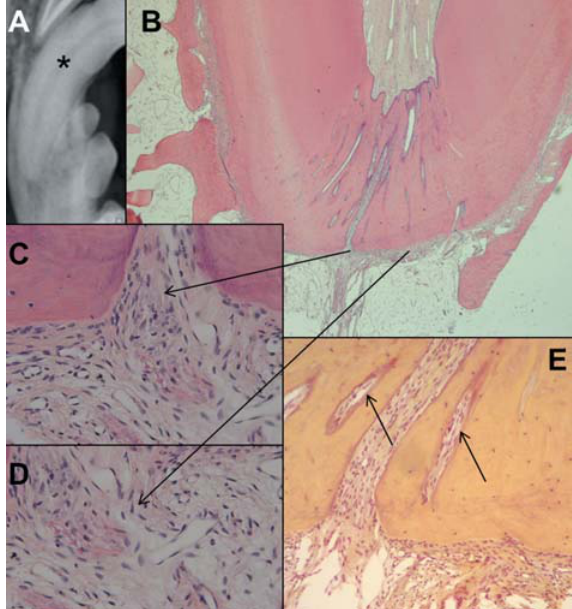
Figure 2- Representative images of the negative control group. (A) Radiographic examination (*) healthy tooth [Original; Rx]. (B) Panoramic view [×100; hematoxylin (cid:14)(cid:13) (cid:3)(cid:7)(cid:15)(cid:11)(cid:12)(cid:13) (cid:16)(cid:17)(cid:18)(cid:19)(cid:18)(cid:20)(cid:21)(cid:18)(cid:13) (cid:16)(cid:22)&’(cid:20)(cid:13) +(cid:11)(cid:10)(cid:28)(cid:13) (cid:11)(cid:12)(cid:26)(cid:5)(cid:4)(cid:4)(cid:5)(cid:6)(cid:7)(cid:25)(cid:9)(cid:13) (cid:11)(cid:12)(cid:27)(cid:10)(cid:6)(cid:25)(cid:5)(cid:6)(cid:3)(cid:13) (cid:5)(cid:12)(cid:28)(cid:13) tissue organization (arrows) [×400; H.E.]. (E) Absence of microorganisms in cementum lacunae (arrows) [×400 Brown and Brenn